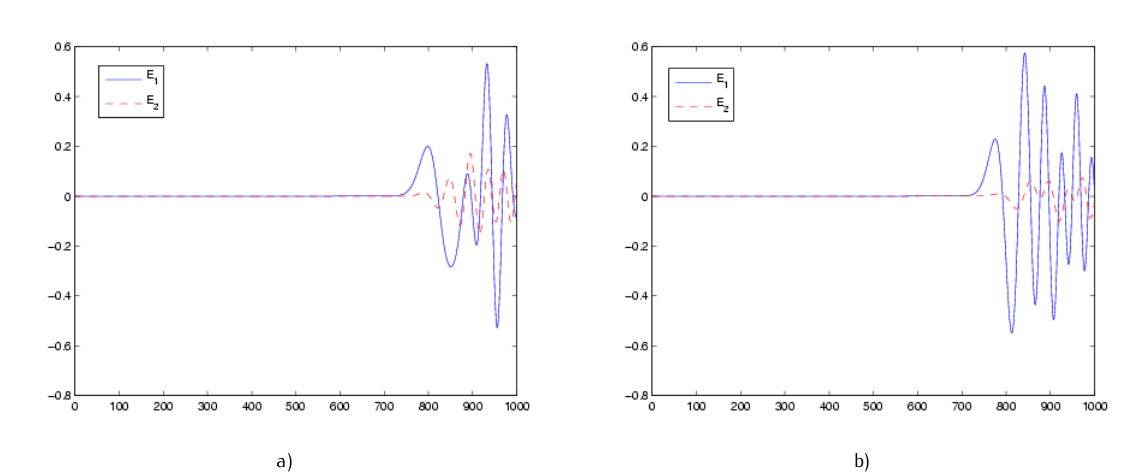
Figure 15. Test 4. Behavior of the computed solution E boundary: a) at the point (1 . 0 ,− 3 . 5) ; b) at the point (1 . 5 ,− 3 . 5) . Here, the mesh size is h = 0 . 125 and the horizontal axis denotes the number of time steps during time T = (0 , 20) . In this figure components of the electric field are defined as E